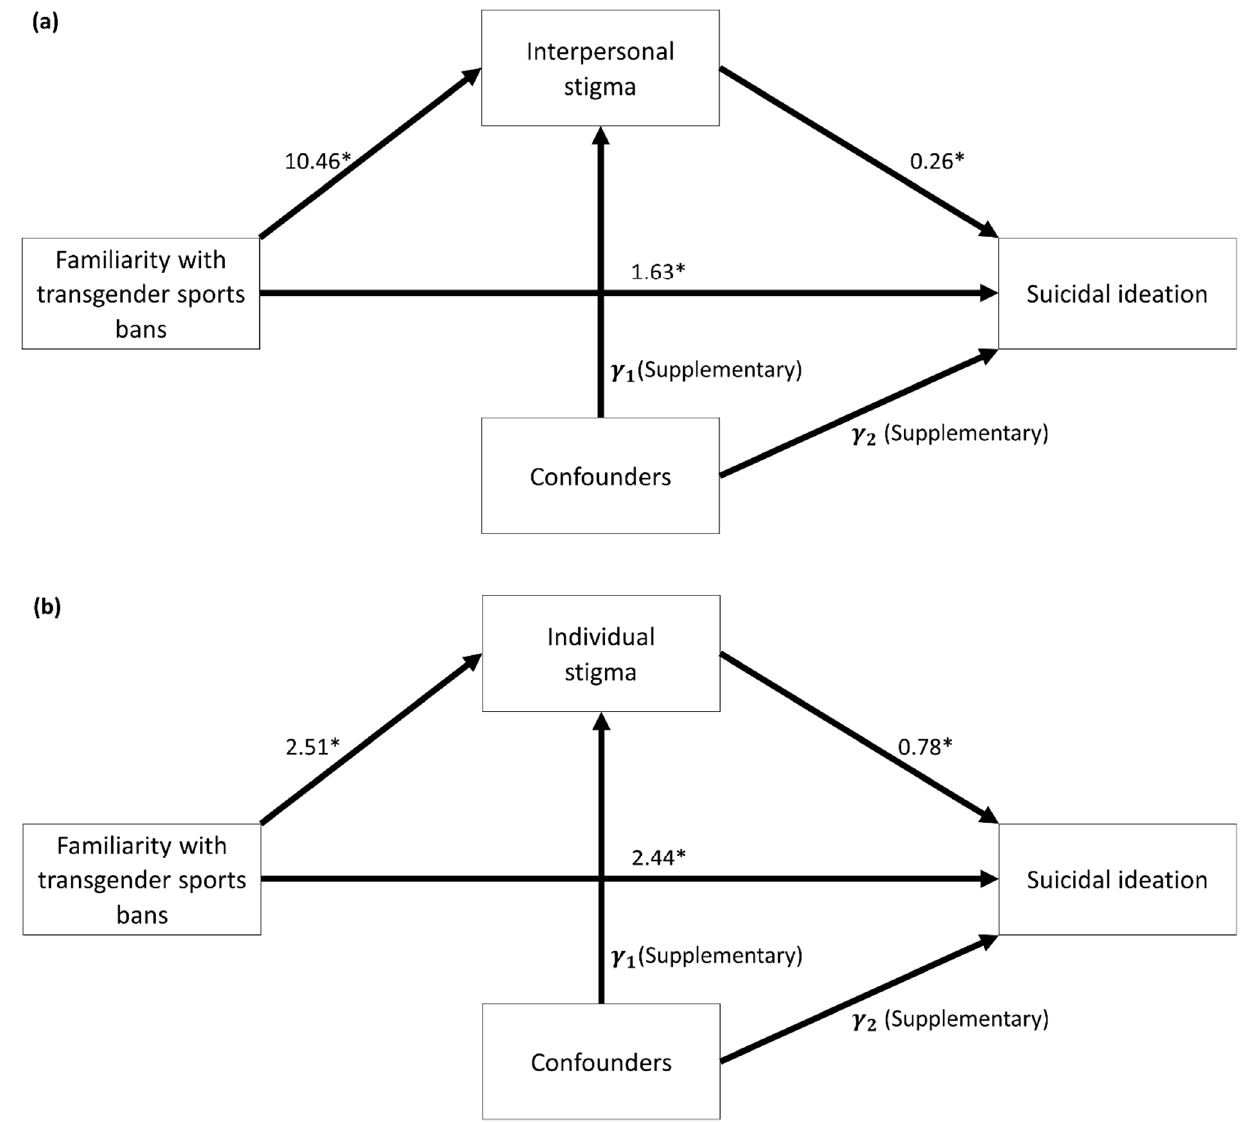
Figure 2. Statistical estimations of univariate mediation analyses for ( a ) interpersonal stigma and ( b ) individual stigma. Each arrow shows the estimated coefficient. * p -value < 0.05.